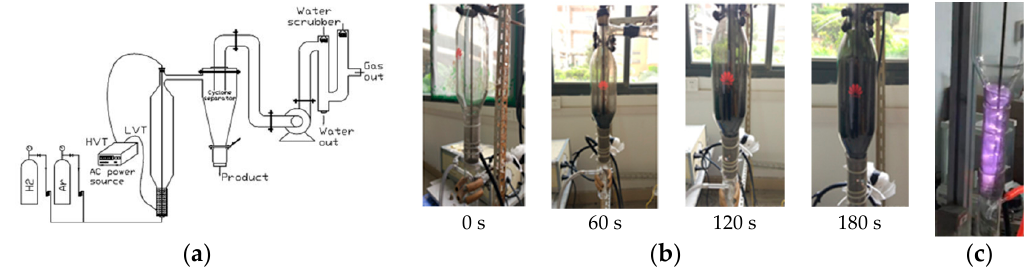
Figure 1. ( a ) Schematic representation of the apparatus used to reduce graphene oxide (GO). Low voltage terminal (LVT) and high voltage terminal (HVT) are connected to the low- and high-voltage terminals, respectively; ( b ) expansion of GO powders after treatment with dielectric-barrier discharge (DBD) plasma for 0, 60, 120, and 180 s, respectively; ( c ) discharge process.